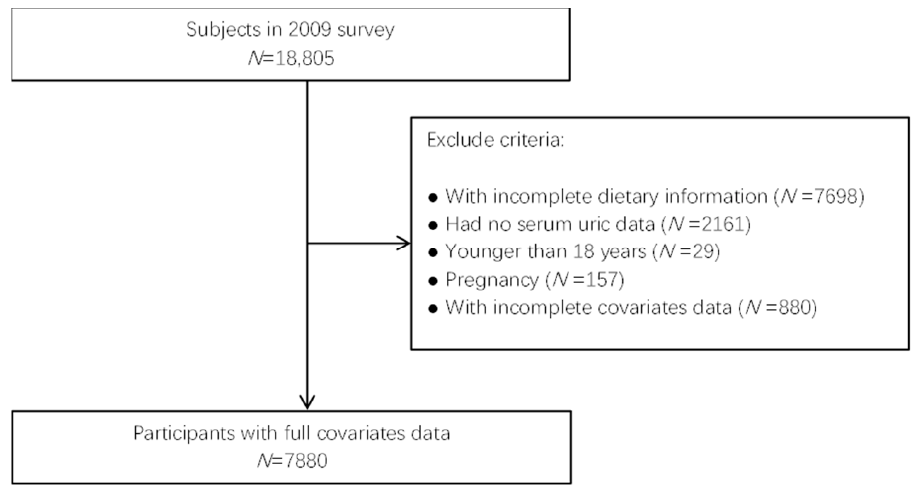
Figure 1. Flow chart for inclusion and exclusion of research subjects.